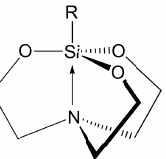
Figure 1. Chemical structures of